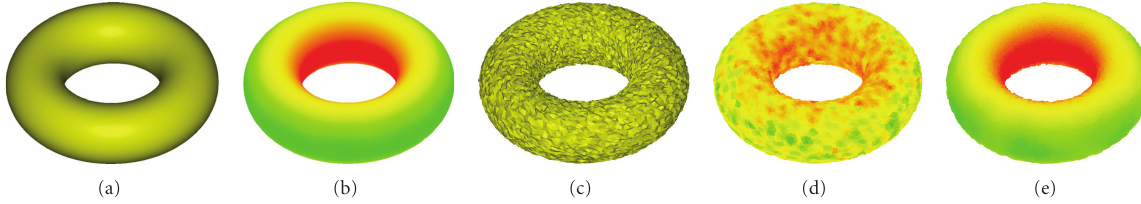
Figure 3: (a) Torus model with R = 2 and r = 1. (b) The accurate mean curvature plot of (a). (c) Gaussian noisy model with h = 0 . 5; (d) Mean curvature plot of (c) by Meyer et al. [11]. (e) Mean curvature plot of (c) by the method in this paper.